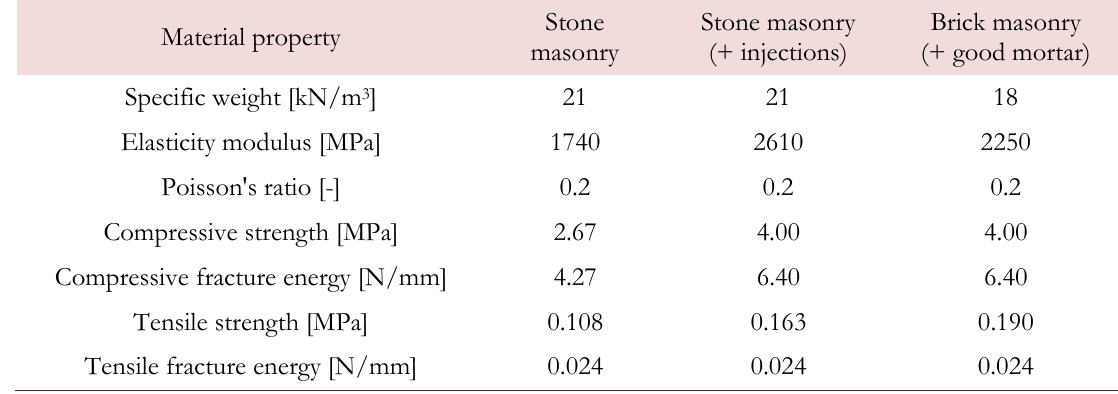
Table 2: Material properties of the different types of masonry considered in the numerical model.